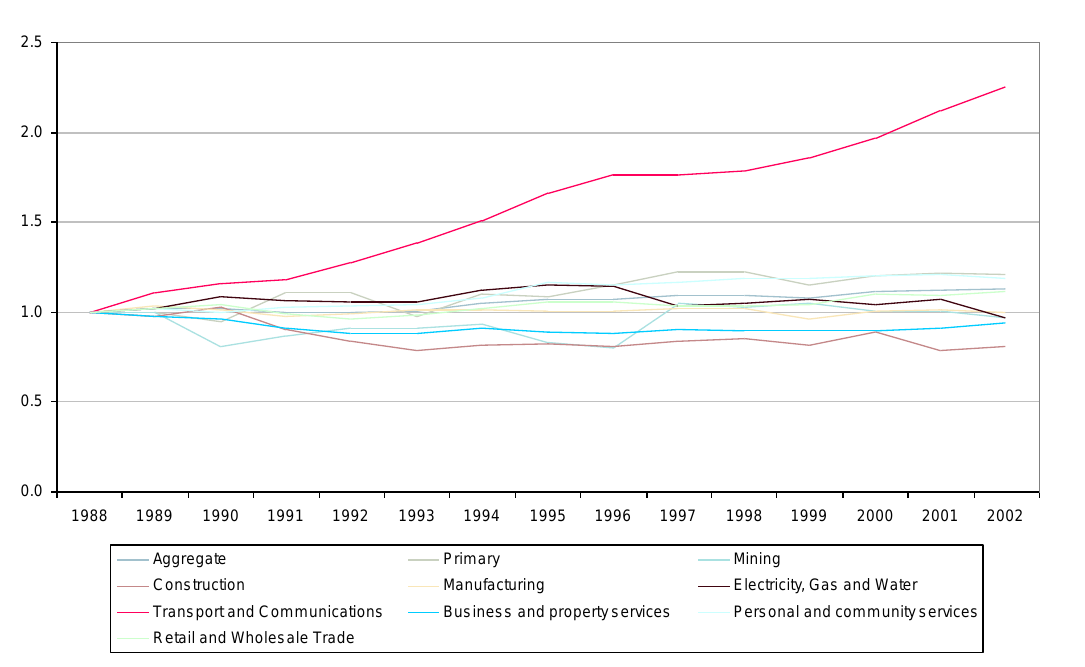
Table 1 Average Multifactor Productivity Growth by Industry